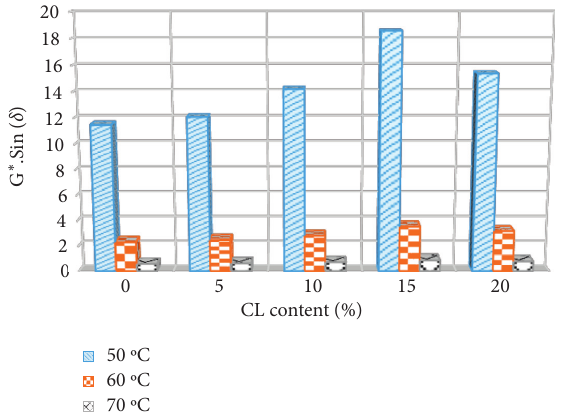
nr ) at different test conditions under 3.2kPa stress level.